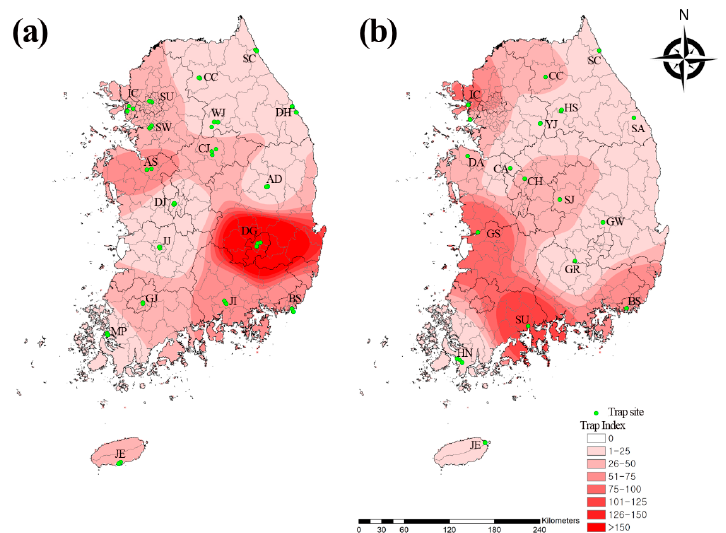
Figure 1. Geographical distribution of mosquitoes in traps at 36 collection sites in ( a ) urban areas and ( b ) migratory bird habitats of the Republic of Korea in 2020. Map color indicates trap index (0 to > 161). Collection traps are indicated by green dots. Trap index represents the number of mos- quitoes per trap per night. SU: Seoul; IC: Incheon; SC: Sokcho; DH: Donghae; SW: Suwon; CC: Chuncheon; WJ: Wonju; SA: Samcheok; HS: Hoengseong; YJ: Yeoju; CJ: Chungju; AS: Asan; AD: Andong; DG: Daegu; DJ: Daejeon; JJ: Jeonju; CA: Cheonan; CH: Cheongju; DA: Dangjin; SJ: Sangju; GW: Gunwi; GR: Goryeong; GS: Gunsan; GJ: Gwangju; MP: Mokpo; JI: Jinju; BS: Busan; SU: Suncheon; HN: Haenam; JE: Jeju. 2.3. Mosquito Species Identification All collected mosquitoes were transferred from the traps to Styrofoam coolers con- taining ice packs. Female mosquitoes were identified and morphologically confirmed using an optical microscope and taxonomic keys [11,12]. 2.4. Molecular Detection of Flavivirus in Mosquitoes All mosquitoes except anophelines were used to detect different flavivirus infec- tions, such as those caused by West Nile virus, Zika virus, JEV, yellow fever virus, and dengue fever virus. The mosquitoes were pooled by species, period of study, and collec- tion site. There were 1–30 individuals per pool. The mosquitoes were homogenized with a Precellys ® CK28-R lysing kit and bead tube for hard tissue homogenization (Bertin Technologies, Bretonneux, France), as well as a Precellys ® evolution homogenizer (Bertin Technologies). Total RNA from the homogenate was extracted with a commercial Be- mires ® viral RNA extraction kit (IVT7001; InVIRUSTech, Gwangju, Republic of Korea), according to the manufacturer’s protocol. To detect the non-structural protein 5 ( NS5 ) gene of flavivirus, qRT-PCR was per- formed with a Clear-MD ® flavivirus real-time RT-PCR detection kit (IVT-M1001KS; InVIRUSTech). The qRT-PCR conditions for each reaction were 15 min at 50 °C for cDNA synthesis, followed by 10 min at 95 °C for inactivation of reverse transcriptase, 40 cycles of denaturation for 10 s at 95 °C, annealing for 10 s at 60 °C, extension for 10 s at 72 °C, and signal reading for 15 s at 80 °C. After amplification, the qRT-PCR products were subjected to a melting curve analysis to verify each product by its specific melting temperature: denaturation at 95 °C for 30 s, annealing at 60 °C for 1 min, followed by a